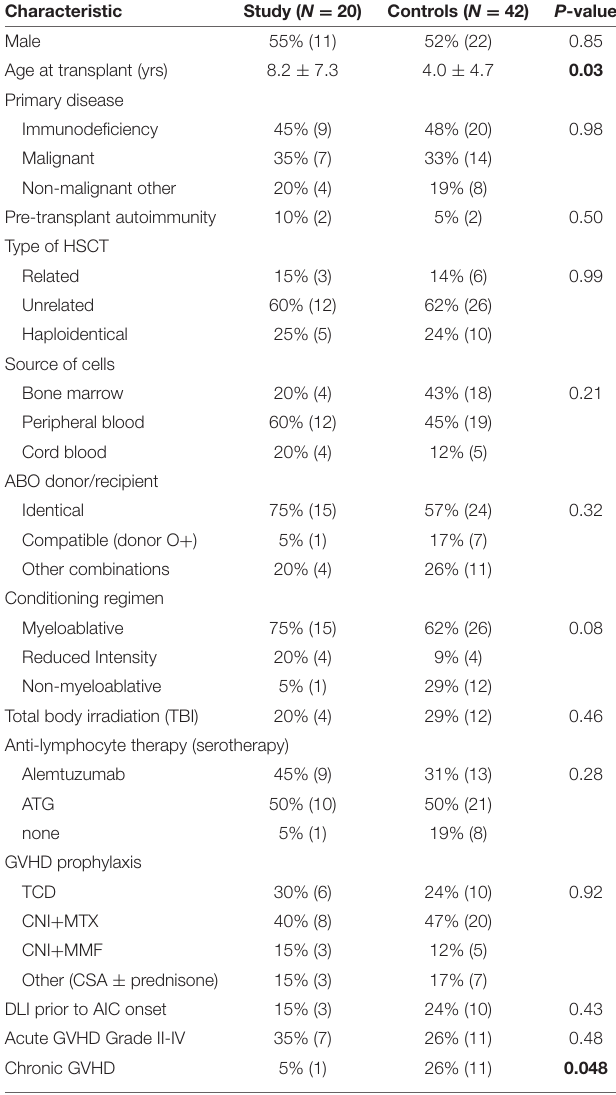
TABLE 1 | Patient characteristics matched by primary disease and HSCT.